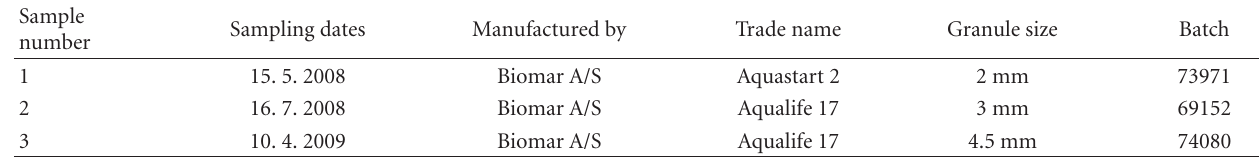
Table 2: Samples of feedstu ff s used.